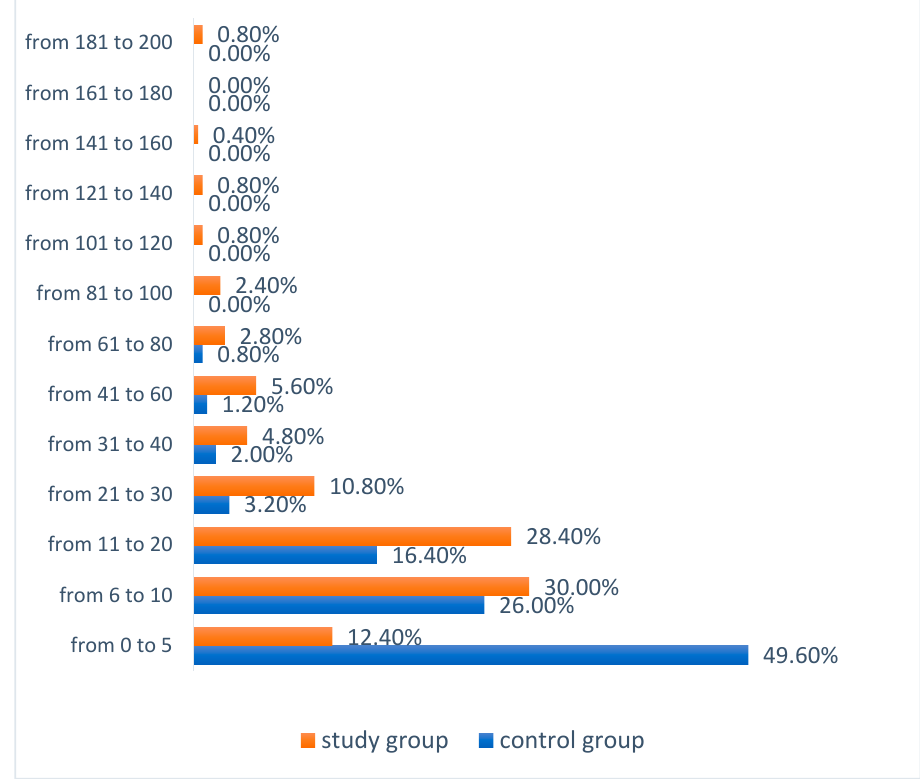
Figure 9. Number of application users marking a particular number of points in the tactile test— Test II. Table 8. Number of points marked in the tactile test—Test I and II.